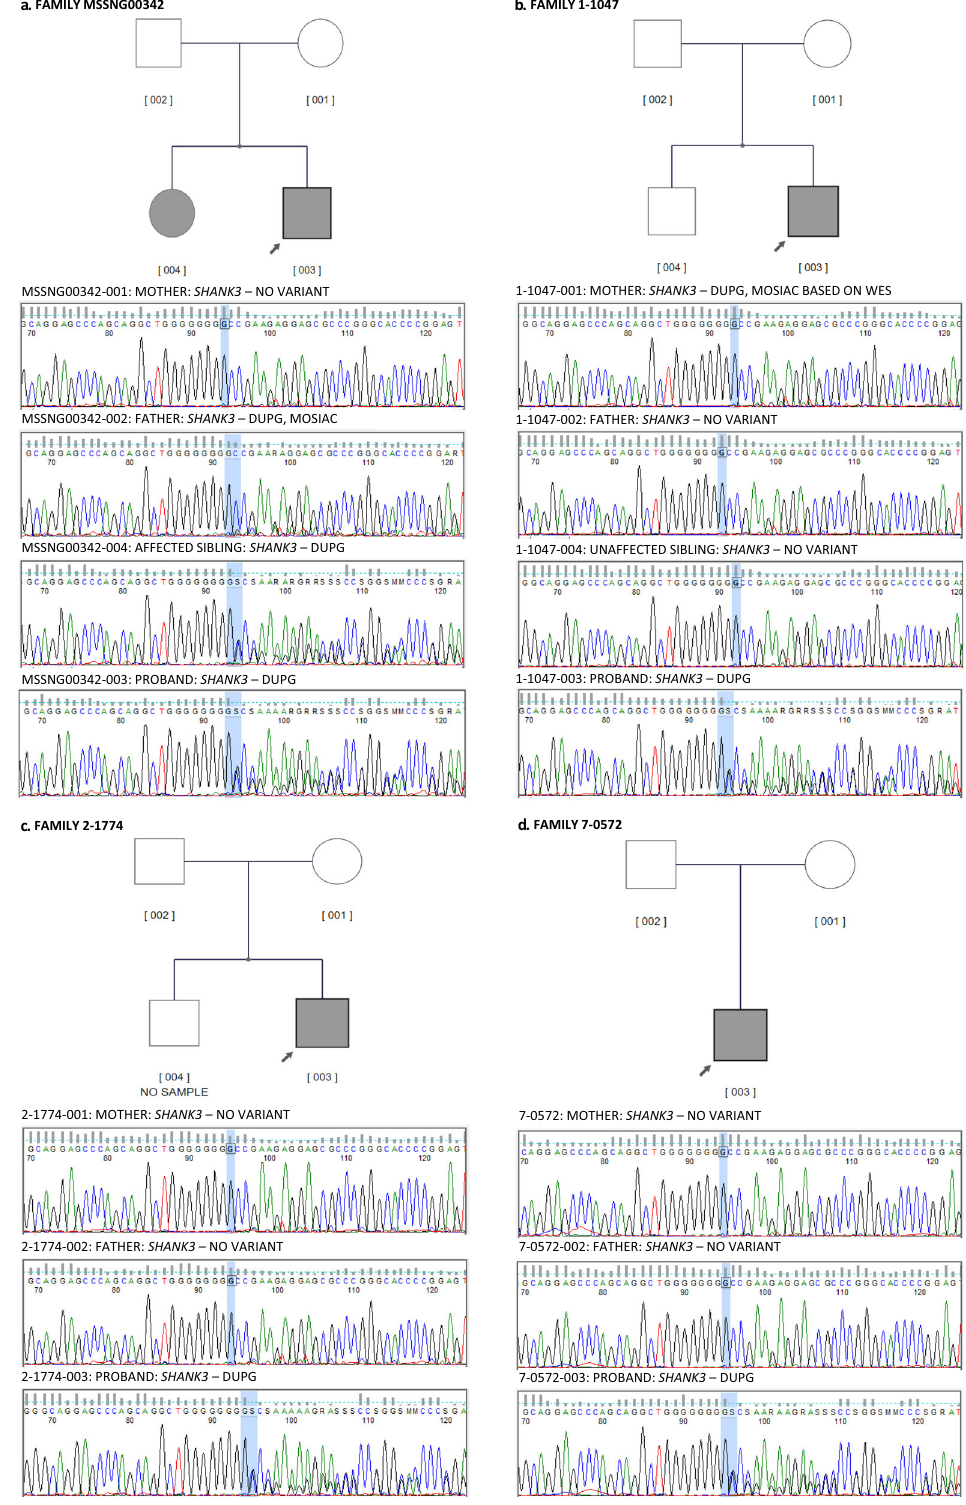
Fig. 1 Pedigrees of MSSNG families reported for the fi rst time in this study and their Sanger sequencing con fi rmation. A Pedigree MSSNG00342; B Pedigree 1 – 1047 (unaffected sibling was targeted Sanger sequenced but was not the whole-genome sequenced); C Pedigree 2-1774 (unaffected sibling sample was not available); D . Pedigree 7 – 0574 (will be available in MSSNG DB7). Gray shapes indicate individuals with an ASD diagnosis and carry the SHANK3